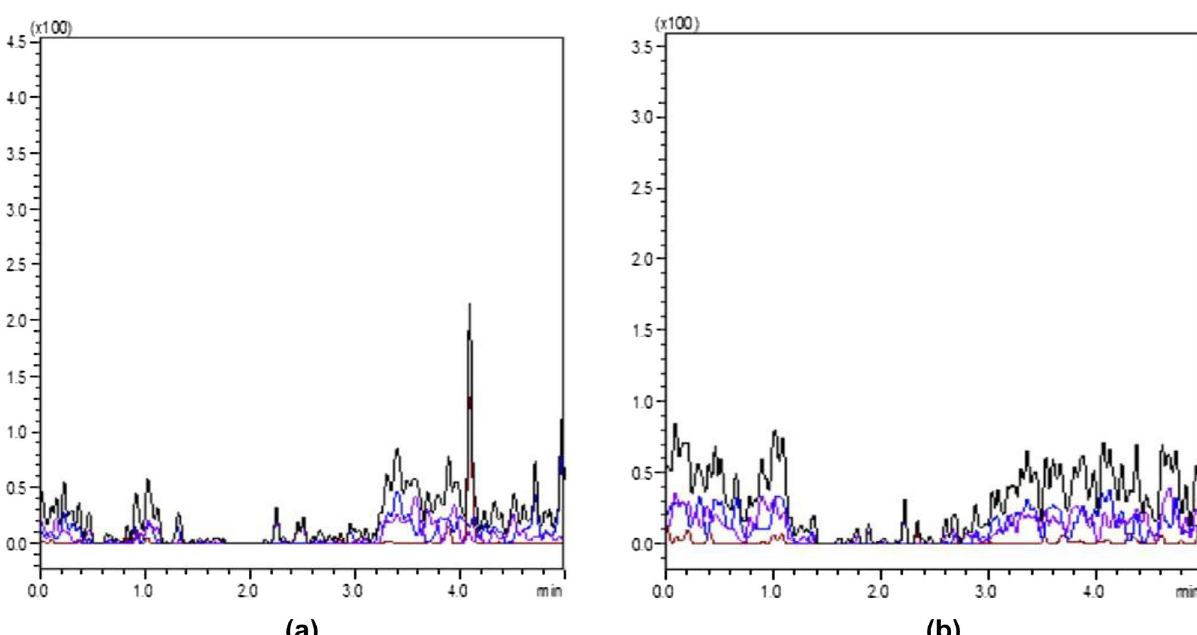
Figure 2. ( a ) LC–MS/MS chromatogram of paddy leaf blank matrix ( b ) paddy soil blank